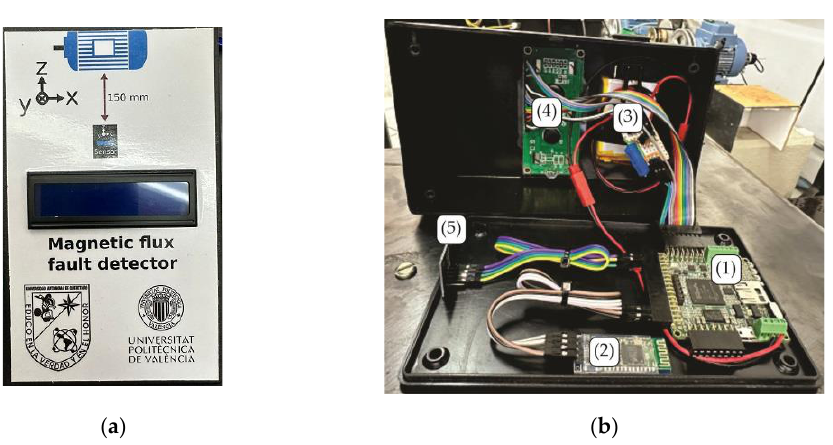
( b ) Figure 5. Experimental setup: ( a ) test bench; ( b ) rolling bearings conditions. The considered elements were the (1) induction motor, (2) alternator as the motor load, (3) output shaft pulleys, (4) transmission belt, (5) location of the bearing under analysis in the frontal support of the shaft, (6) bearing with a healthy outer race, (7) bearing with a 3 mm hole in the outer race, and (8) bearing with a 5 mm hole in the outer race. 4.2. Stray Magnetic Flux Fault Detector Regarding this tool developed, Figure 6a presents the physical SMFFD system for